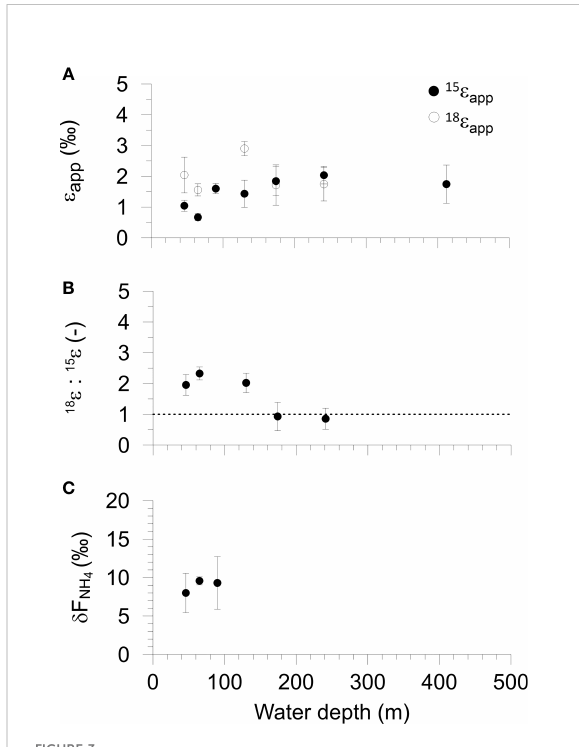
FIGURE 3 Benthic chamber isotope results versus water depth on the Mauritanian margin. (A) Fractionations of N-NO 3- ( 15 ϵ app ) and O- NO 3- ( 18 ϵ app ). (B) The ratio 18 ϵ app : 15 ϵ app , where the dashed line shows unity. (C) The d 15 N of the NH 4+ fl ux from the sediment. Error bars represent the standard error of the regression slopes (see Methods). Data are tabulated in Table S1 in the